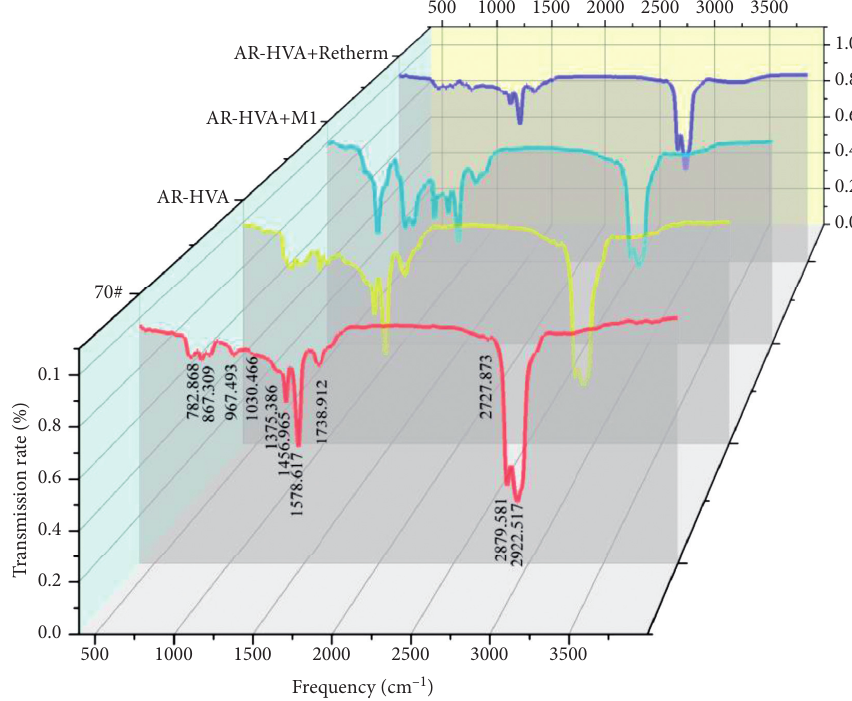
Figure 8: FTIR spectra of different